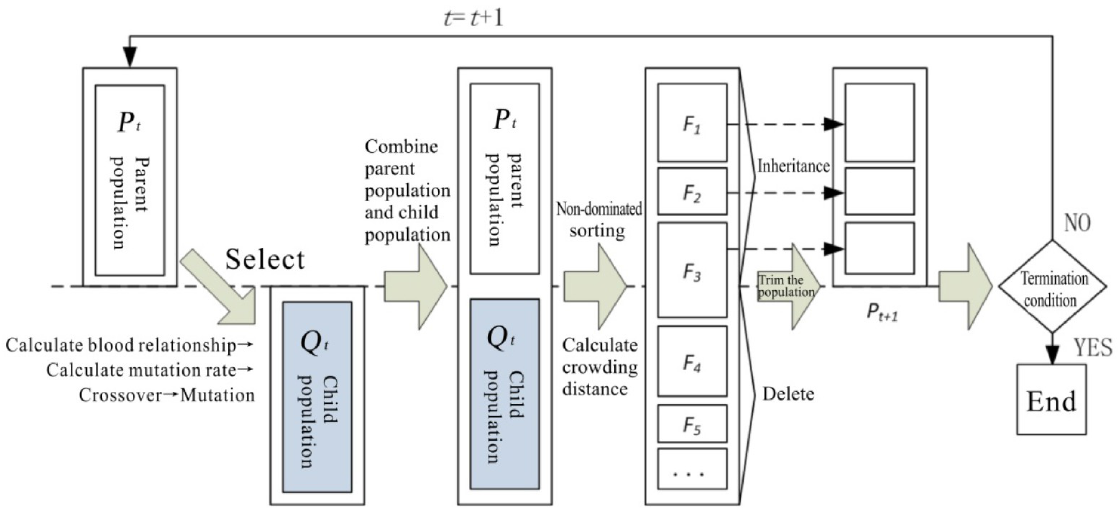
Figure 7. Process of NSGA-II based on blood